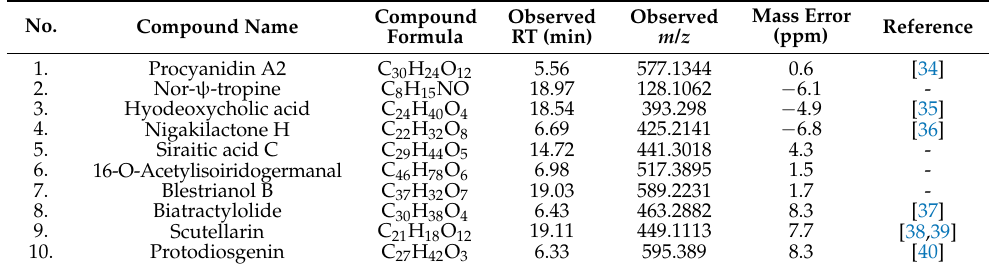
Table 1. The main identified constituents of the Artemisia santolinifolia ethanol extract